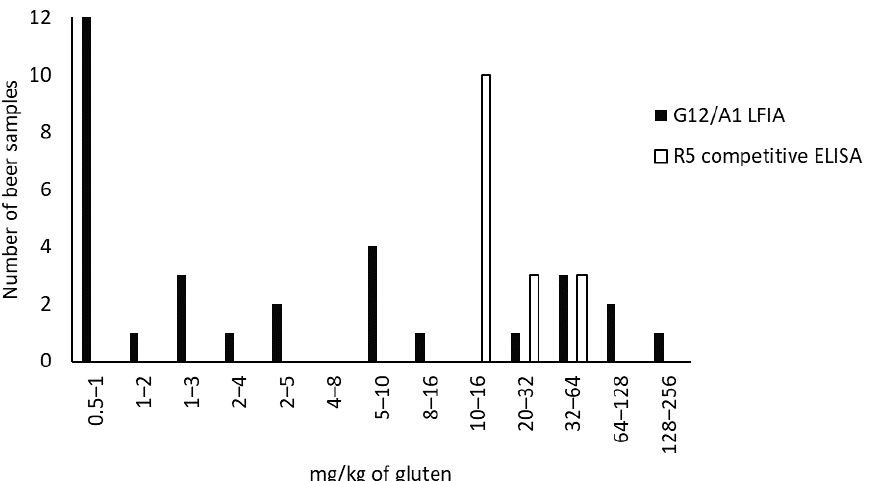
Figure 4. Number of beers in each gluten mg/kg range resulting from the G12/A1 LFIA or R5 competitive ELISA. ELISA, enzyme-linked immunosorbent assay; LFIA, lateral flow immunochromatographic assays; ppm, parts per million.